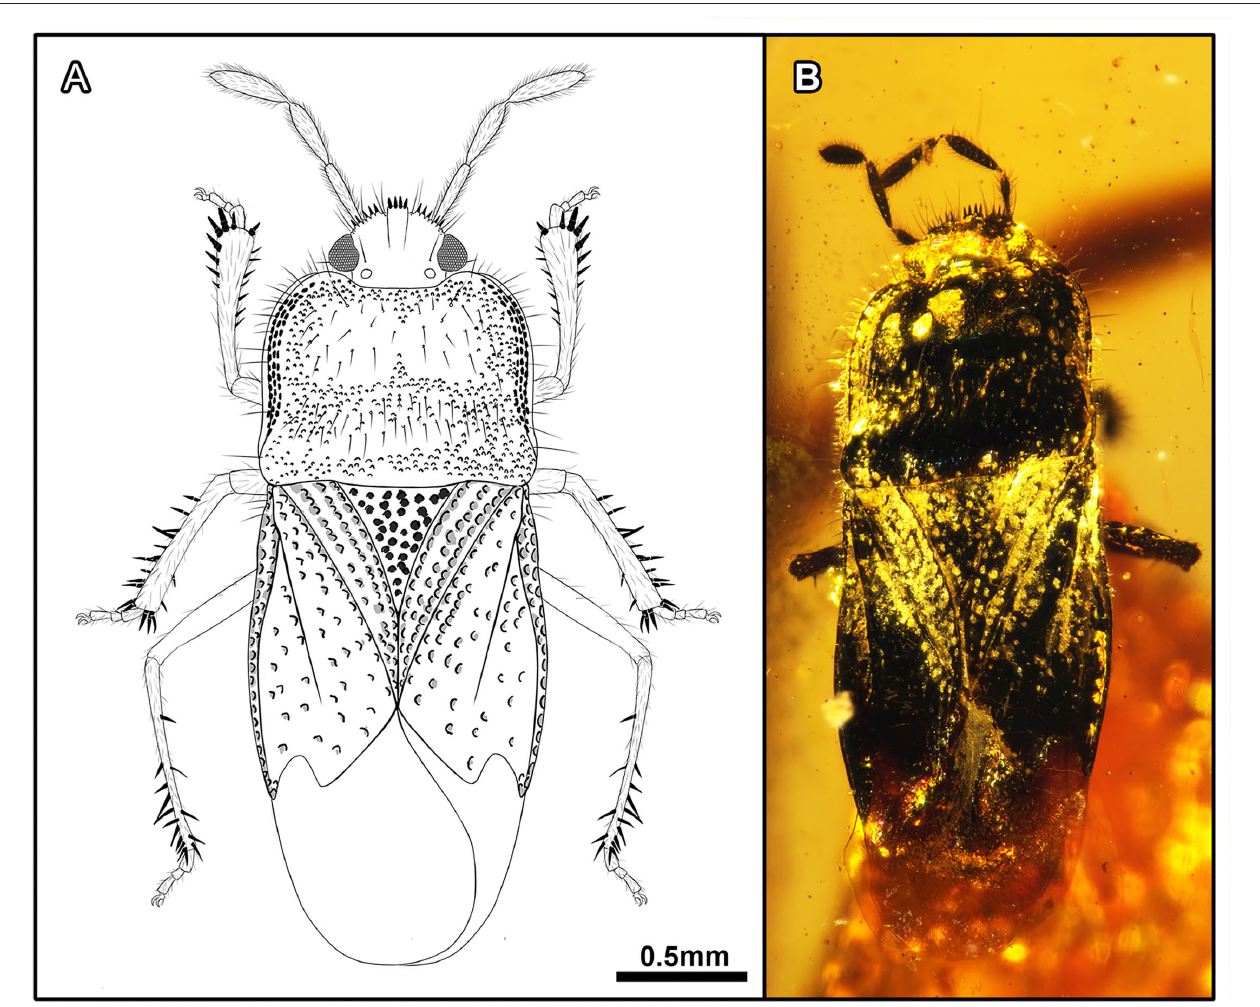
FIGURE 1 | Acanthamnestus atridorsus gen. et sp. nov., in mid-Cretaceous amber from Myanmar, Holotype CNU-HET-MA2019002 (male). (A) Line drawing habitus in dorsal view. (B) Photograph habitus in dorsal view. Scale bars: A = B = 0.5 mm.